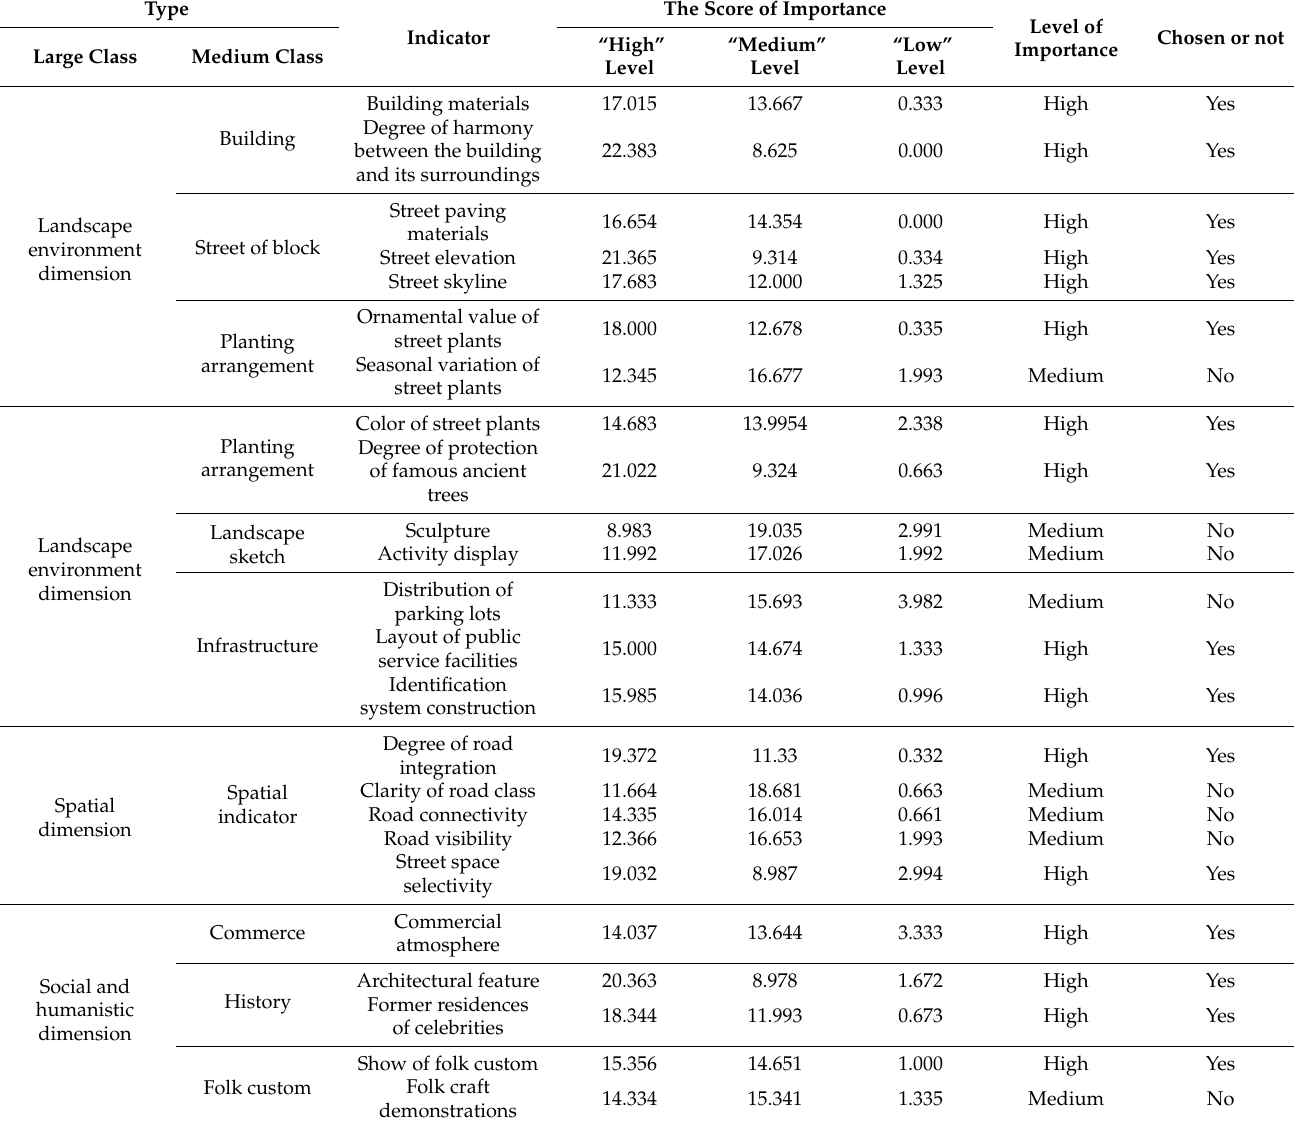
Table 2. The importance of landscape indicators of Three Lanes and Seven